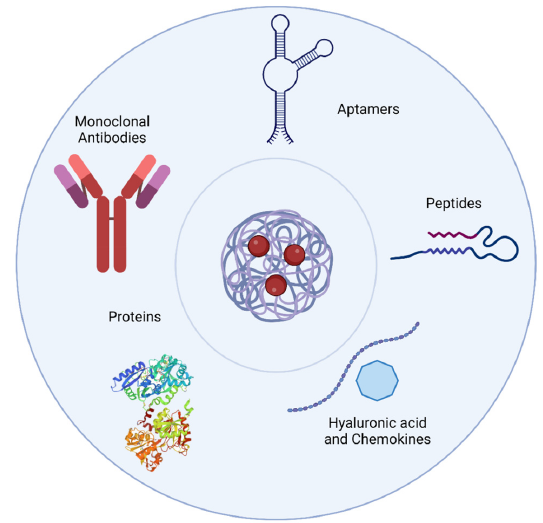
Figure 2. Types of targeting molecules available for PNPs functionalization. Different kinds of mol- ecules can be used for the targeted delivery of nanoparticles. The main classes are monoclonal anti- bodies, oligonucleotide aptamers and other molecules such as like proteins or chemokines. Created with BioRender.com.(accessed on 2 nd December 2022)